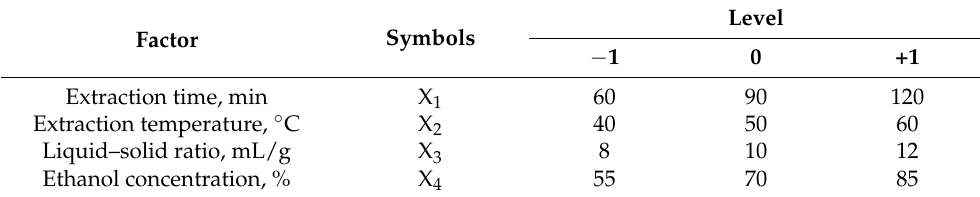
Table 1. Factors and levels in Box–Behnken design.